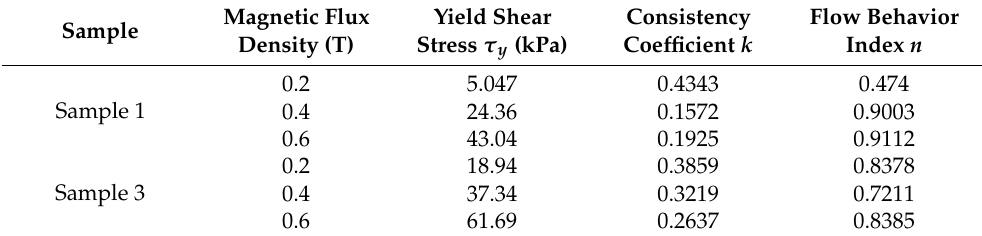
Table 2. Key parameters of fitting curves between shear stress and shear